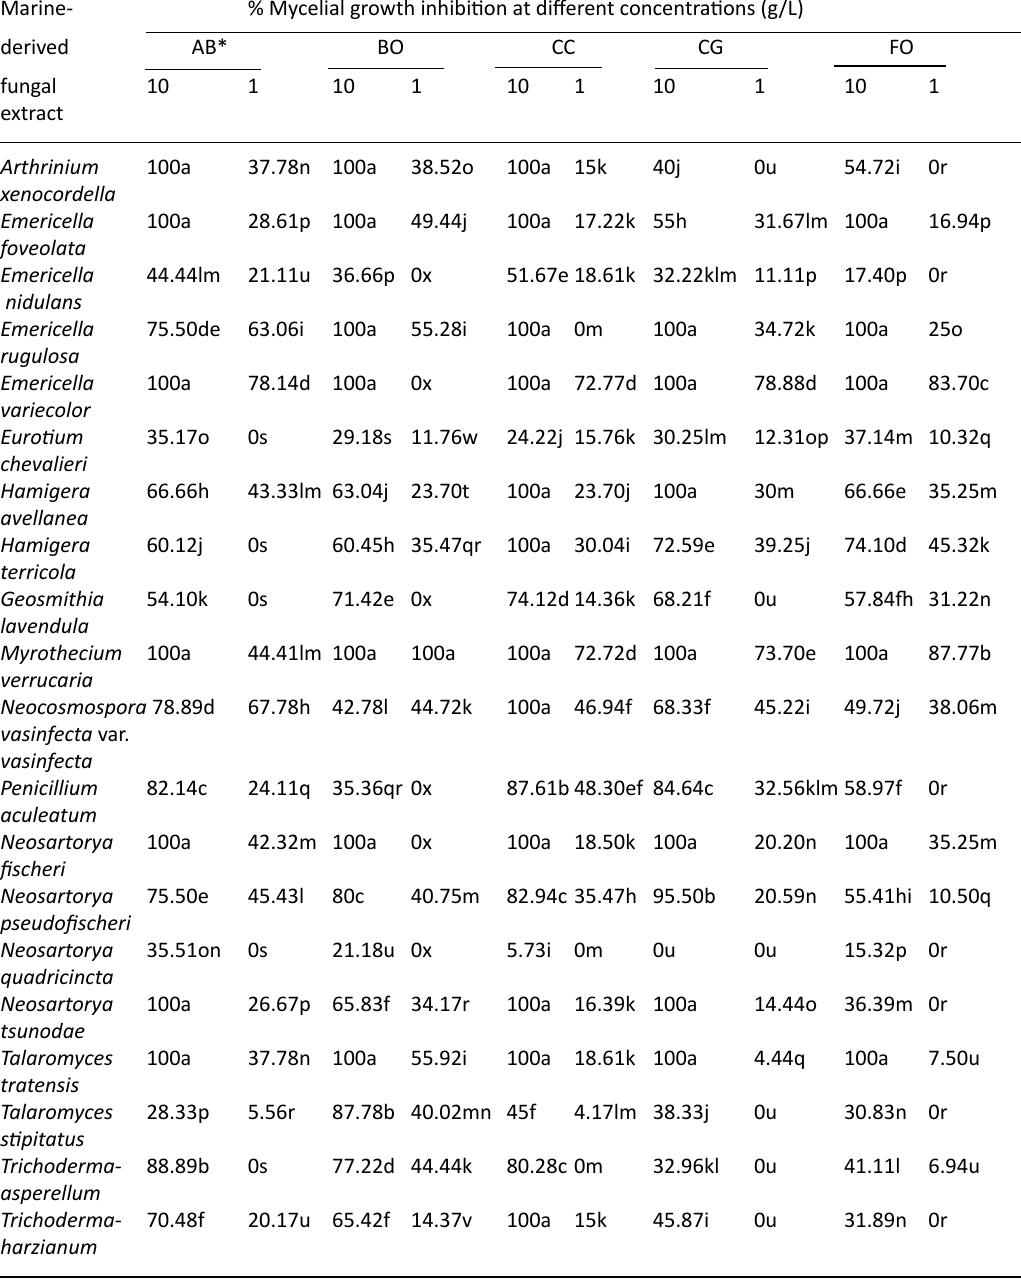
table 3. Antifungal effects of marine-derived fungal extracts on ten plant pathogenic fungi by using the dilution